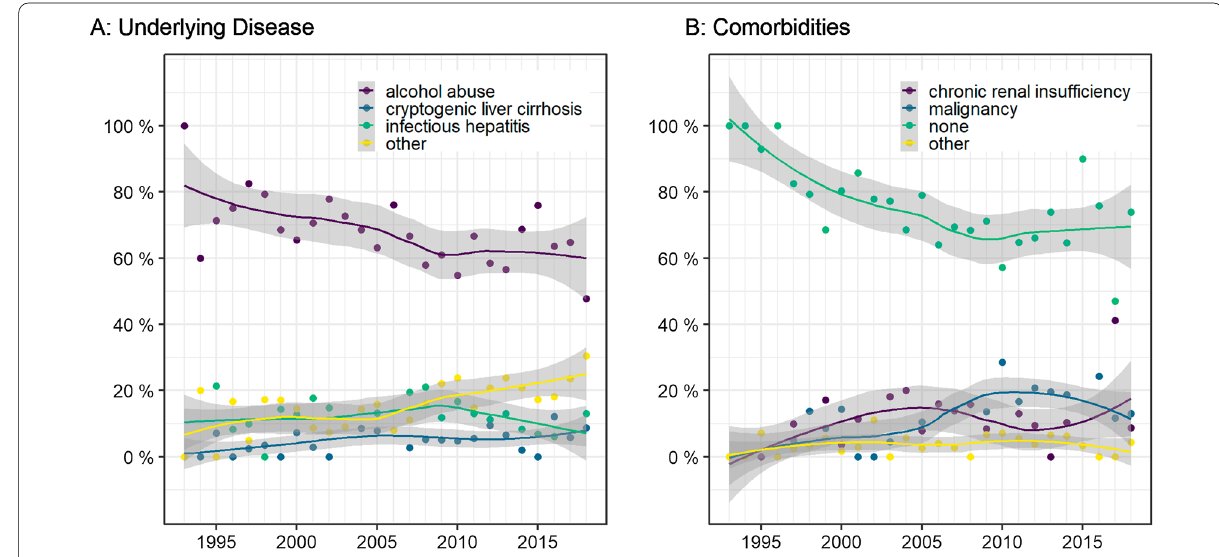
Fig. 1 Clinical data by year. a Underlying disease. Share of the three most frequent underlying diseases over the observation period. For a summary of all underlying diseases see appendix. b Comorbidities. The proportion of patients with comorbidities increased over time